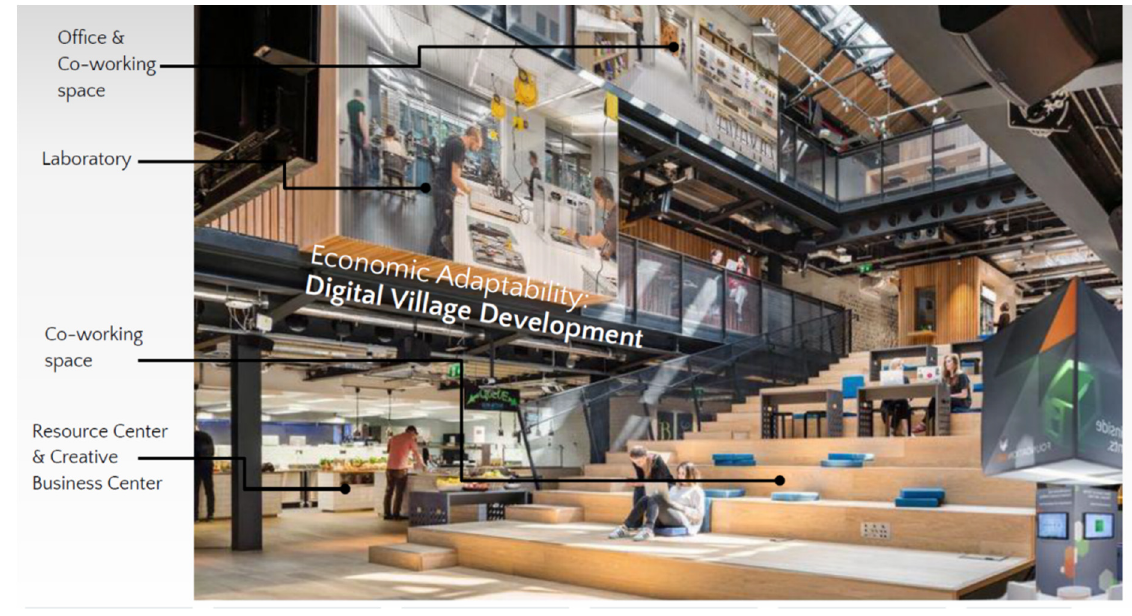
Figure 11. Collage of Digital-Village workspace, with an emphasis on co-working space. Graph- ics credits to Tanavara Chawanid, Paveena Kusaranukun, Manita Intarachaisri, Yuto Motani, UD327